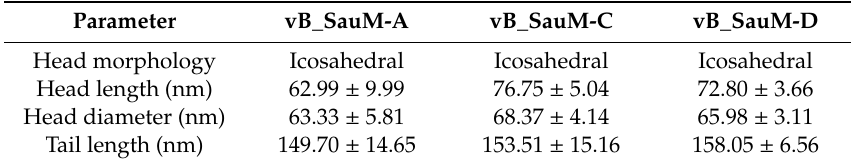
Figure 1. Transmission electron micrographs (TEM) of vB_SauM-A ( A ), vB_SauM-C ( B ), vB_SauM-D ( C ). Table 1. Dimensions of phages vB_SauM-A, vB_SauM-C and vB_SauM-D obtained from transmission electron micrographs.